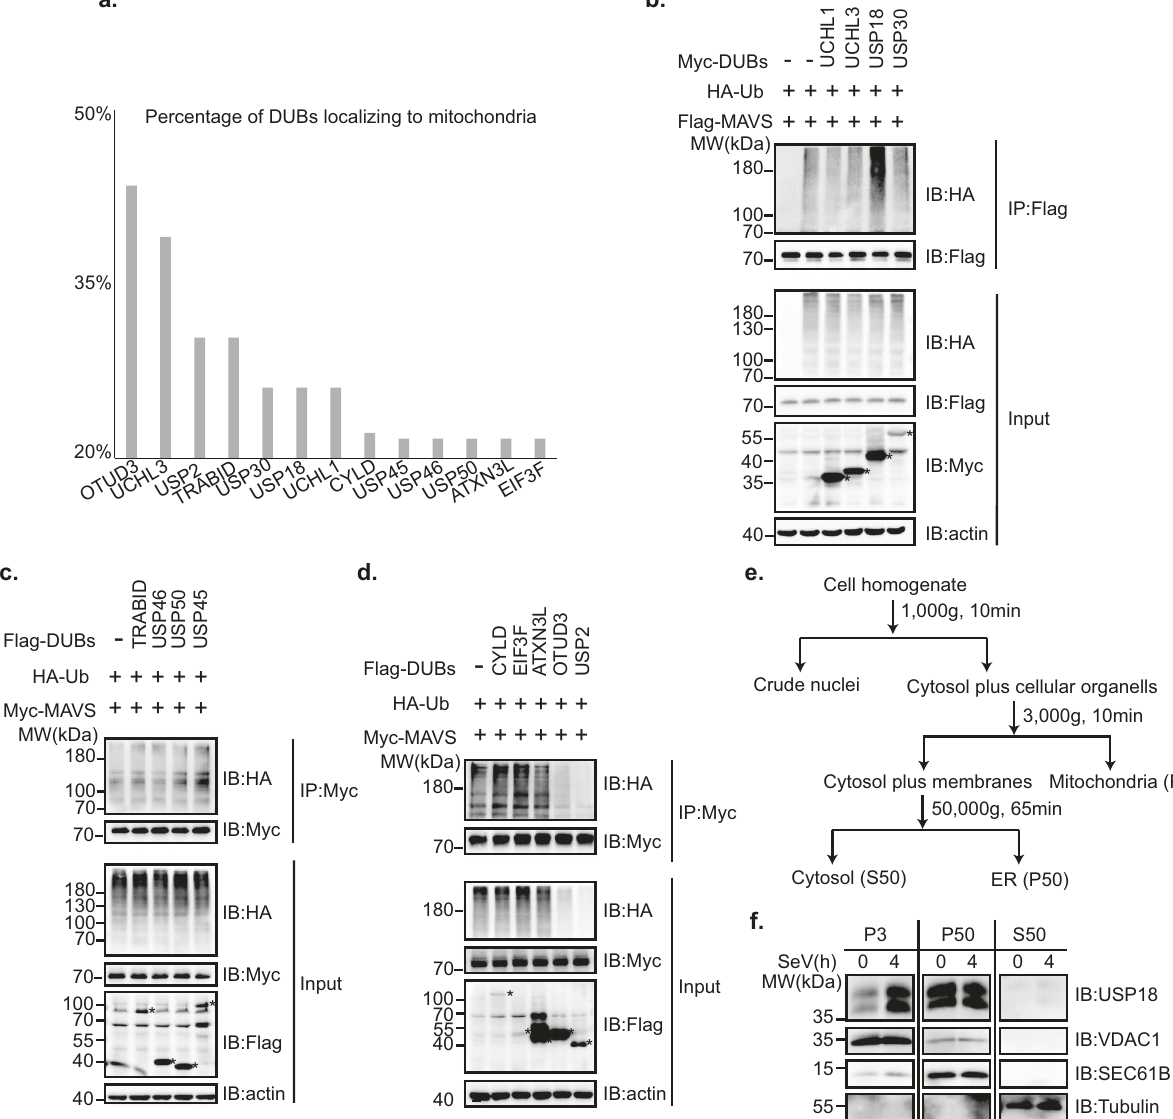
Fig. 1 Identi fi cation of USP18 that regulates the polyubiquitination of MAVS. a Illustration of DUBs likely to be distributed in mitochondria. The bar graph illustrates the DUBs with >20% possibility present in mitochondria according to the prediction of Psort Wolf software. b – d Immunoprecipitation analysis of ubiquitination of MAVS in HEK293T cells transfected with the plasmids expressing Flag-MAVS ( b ) or Myc-MAVS ( c , d ), HA vector or HA-WT ubiquitin (Ub), together with indicated DUBs. After 24 h of transfection, the cells were lysed and immunoprecipitated with Anti-Flag magnetic beads ( b ) or Anti-Myc magnetic beads ( c , d ). Cell lysates and immunoprecipitates were analyzed by immunoblot with indicated antibodies. Actin was used as the loading control throughout. e Schematic diagram to isolate the mitochondria and ER fraction. f Immunoblot analysis of USP18 from the mitochondrial (P3), ER (P50), and cytoplasmic (S50) fraction of THP-1 infected with SeV for indicated time points. VDAC1, SEC61B, and tubulin were used as the mitochondrial, ER, and cytosolic markers, respectively. Asterisk was marked right next to the band corresponding to the DUBs in Fig. 1b – d. NATURE COMMUNICATIONS| (2021) 12:2970